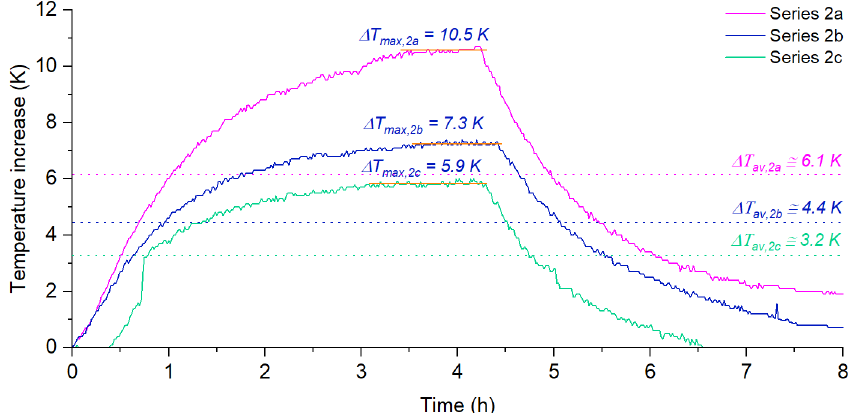
Figure 9. The increase in the temperature of the ventilation air when the SAH operated as a solar chimney and airflow was set to 100 m 3 /h (Series 2a), 150 m 3 /h (Series 2b), and 200 m 3 /h (Series 2c). Table 7. Summarization of the increase in the temperature of the ventilation air when the SAH op- erated as a solar chimney and airflow was set to 100 m 3 /h (Series 2a), 150 m 3 /h (Series 2b), and 200 m 3 /h (Series 2c).